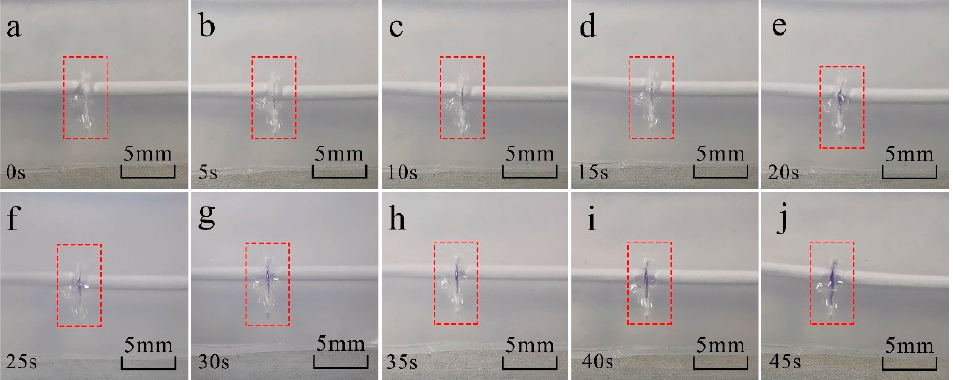
Figure 7. The healing agent (purple) spreading in a formed wound and spilling out over the artificial skin sample surface. ( a – j ) Five seconds between each optical image, from 0 s to 45 s.